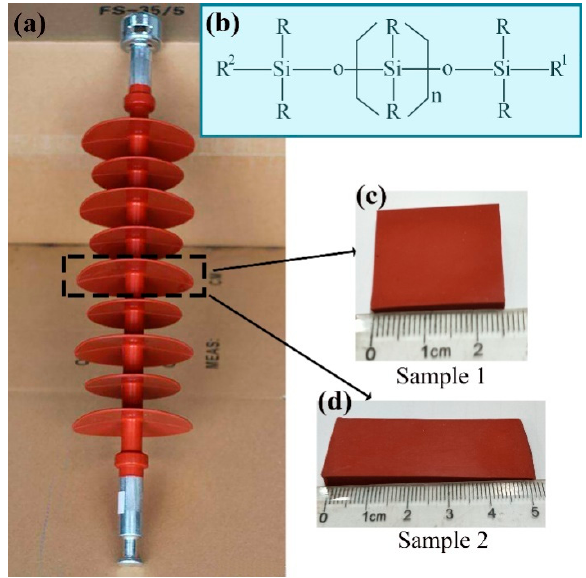
Figure 1. ( a ) Composite insulator; ( b ) silicone rubber molecular formula; ( c ) square sample; ( d ) rectangular sample.